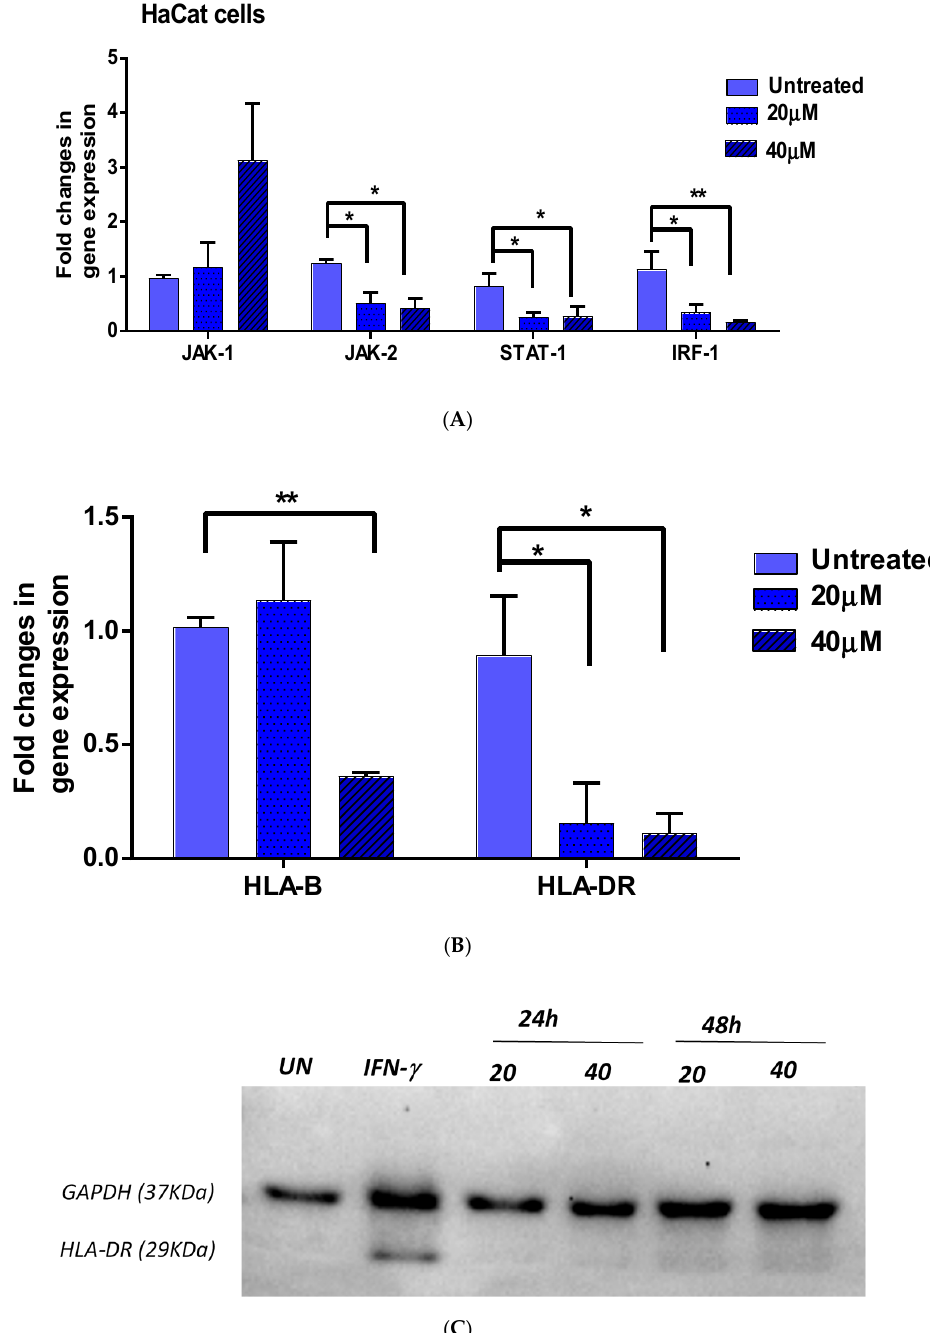
Figure 3. The effect of EGCG treatment on IFN- γ downstream genes in HaCat cells. The effect of EGCG treatment on IFN- γ downstream genes in the HaCat cell line. Following induction with IFN- γ , HaCat cells were treated with 40 µ M EGCG for 48 h and expression of IFN- γ downstream genes was investigated by Q-PCR. CT values were normalised to GAPDH and differential expression (2ˆ − ∆∆ CT) of AA candidate genes in EGCG treated samples was calculated against untreated samples ( A ) QPCR results for STAT1, JAK1, JAK2, and IRF-1. ( B ) QPCR results for HLA-B and HLA-DR . Data represented as mean ± SEM ( n = 4). Significant difference * p < 0.05. ** p < 0.01. ( C ) Cells were induced with IFN- γ for 48 h then treated with 20 or 40 µ M EGCG for 24 or 48 h. Proteins were extracted and Western blot performed using GAPDH or HLA-DR antibody.